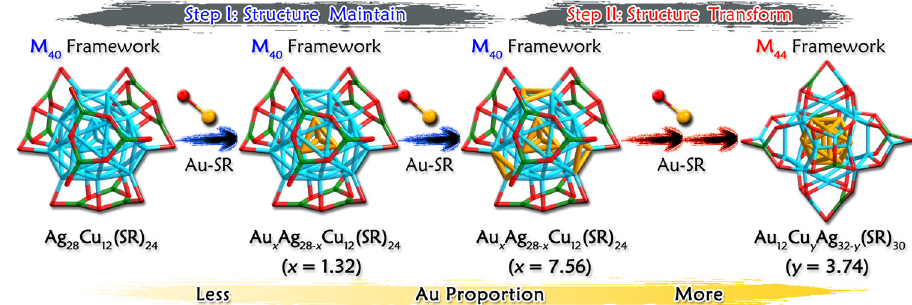
Fig. 2 Illustration of Au-alloying-induced structural evolution. Step I contains the Au-doping processes from Ag 28 Cu 12 (SR) 24 to Au x Ag 28- x Cu 12 (SR) 24 ( x = 1.32) and then to Au x Ag 28- x Cu 12 (SR) 24 ( x = 7.56), in which processes the M 40 (SR) 24 framework retains. Step II is the Au-doping process from Au x Ag 28- x Cu 12 (SR) 24 ( x = 7.56) to Au 12 Cu y Ag 32- y (SR) 30 ( y = 3.74), in which process the M 40 (SR) 24 framework transforms into M 44 (SR) 30 (M = Au/Ag/Cu). The Au proportion gradually increases with the nanocluater evolution from Ag 28 Cu 12 (SR) 24 to Au x Ag 28- x Cu 12 (SR) 24 ( x = 1.32), Au x Ag 28- x Cu 12 (SR) 24 ( x = 7.56), and Au 12 Cu y Ag 32- y (SR) 30 ( y = 3.74). Color labels: light blue, Ag; orange, Au; green, Cu; red, S. All C and H atoms are omitted for transformation (Supplementary Fig. 11a). The changes of UV-vis contained two stages: (stage 1, from Ag 28 Cu 12 (SR) 24 to Au x Ag 28- x Cu 12 (SR) 24 ) eight isoabsorption points at 360, 385, 420, 445, 485, 550, 570, and 640 nm were observed (Supplementary Fig. 11b); (stage 2, from Au x Ag 28- x Cu 12 (SR) 24 to Au 12 Cu y Ag 32- y (SR) 30 ) three isoabsorption points at 400, 485, and 510 nm were detected (Supplementary Fig. 11c). The observation of these isoabsorption points suggested that the overall cluster transformation was a proportional conversion. Accordingly, both transformations from Ag 28 Cu 12 (SR) 24 to Au x Ag 28- x Cu 12 (SR) 24 and from Au x Ag 28- “ intramolecular x Cu 12 (SR) 24 to Au 12 Cu y Ag 32- y (SR) 30 followed an rearrangement ” approach, but not an “ intermolecular decom-